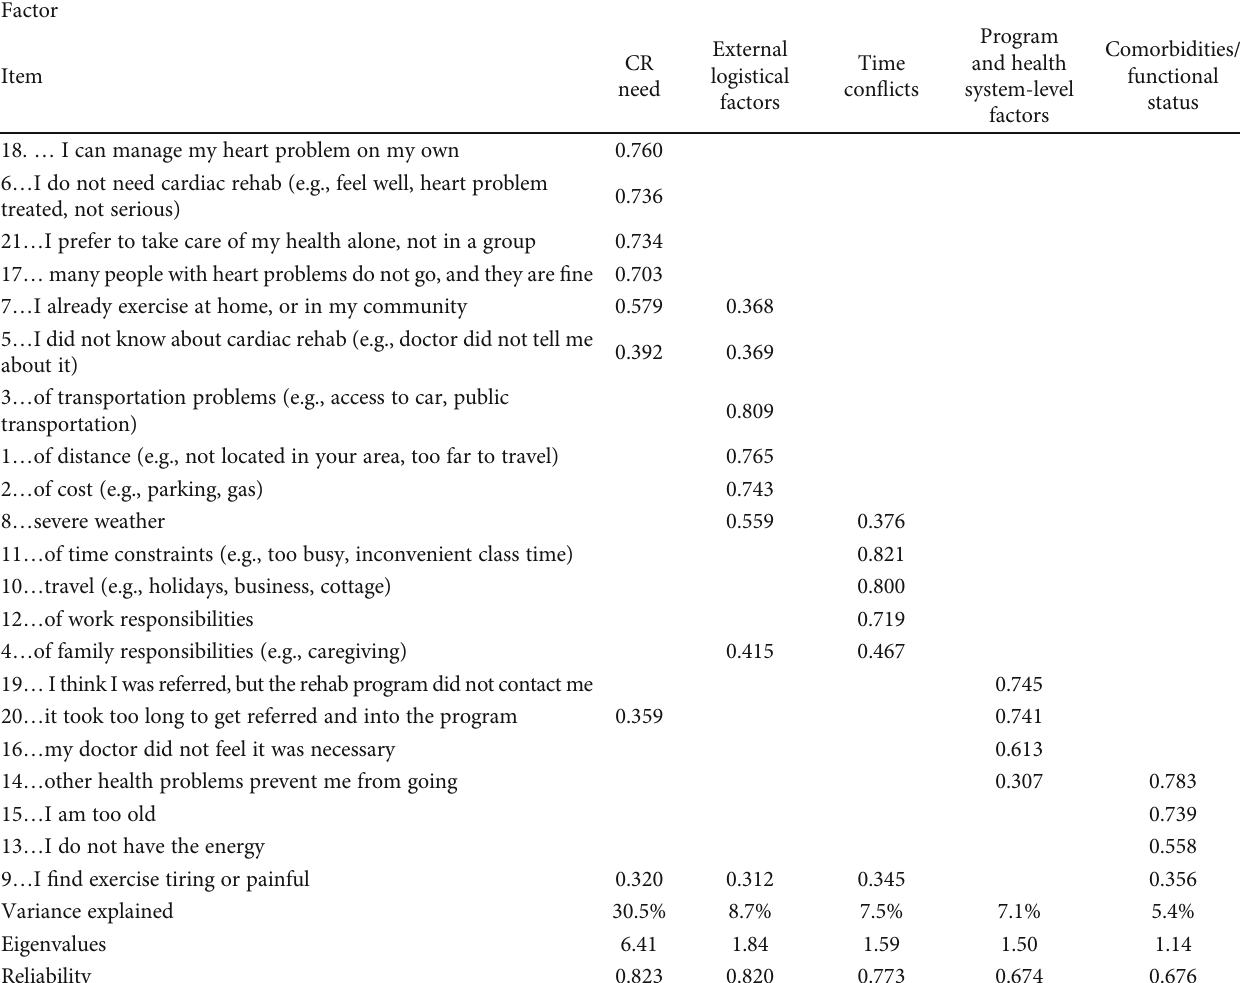
Table 3: Exploratory factor analysis of the Chinese/Mandarin version of CRBS, n = 380